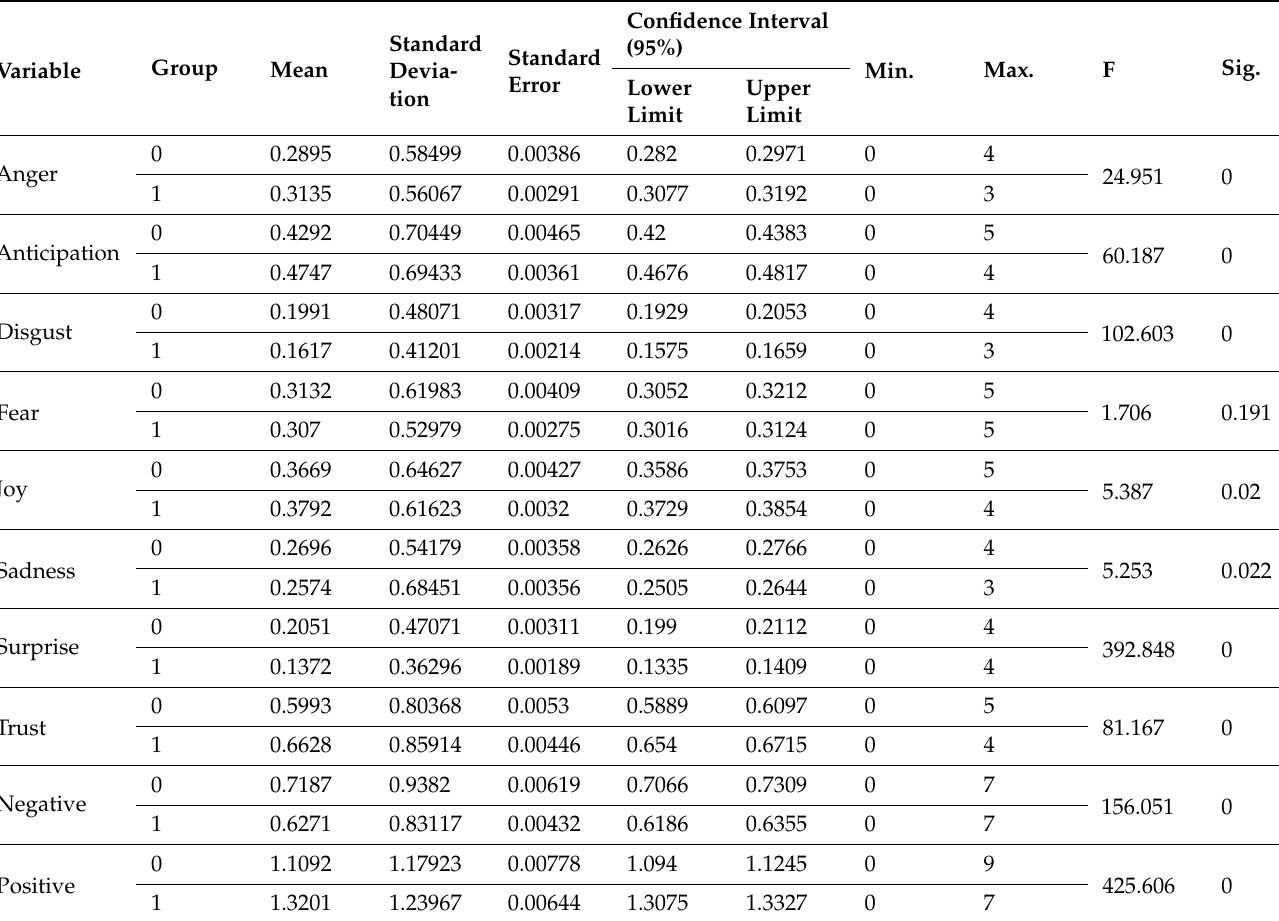
Table 5. ANOVA Period 1, for tweets (0) and retweets (1).